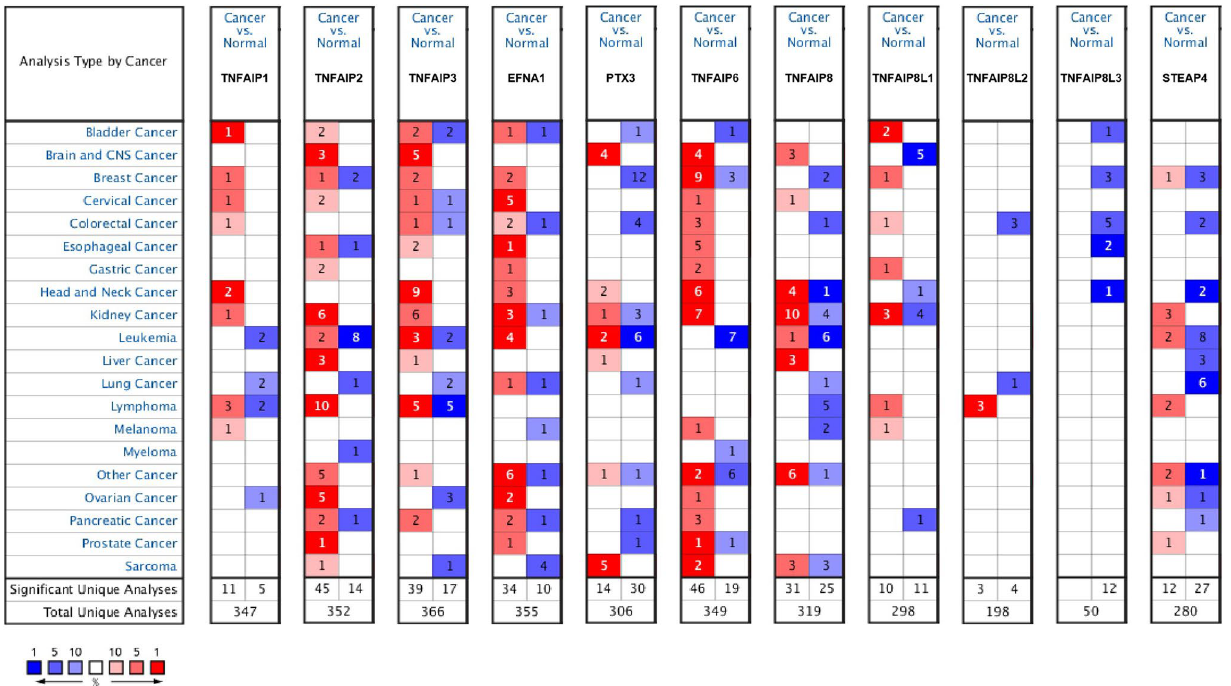
Figure 1. mRNA levels of TNFAIPs in HNC. The figure shows the numbers of datasets with statistically significant upregulation (red) or downregulation (blue) of TNFAIPs at the mRNA level